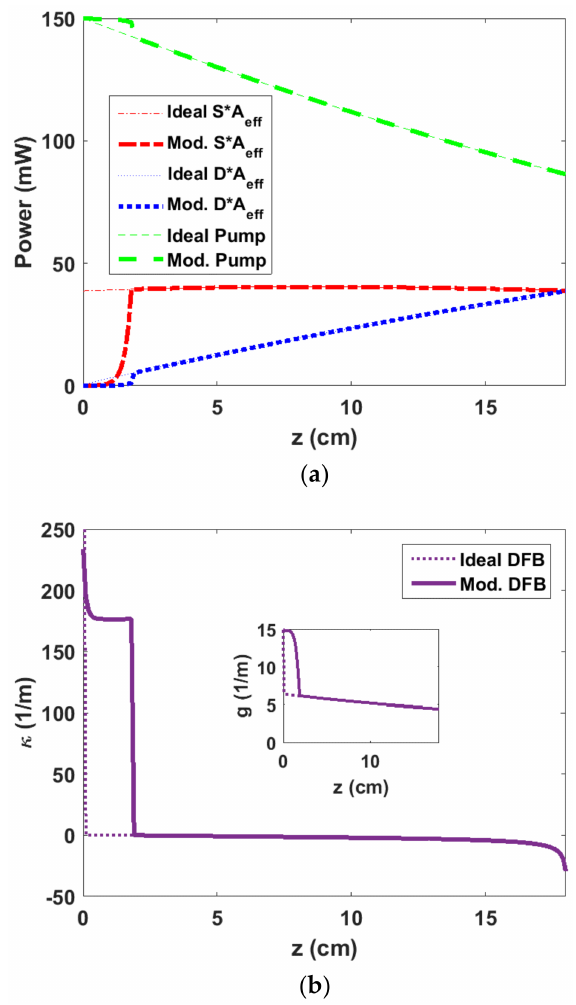
Figure 5. ( a ) Modified distribution of SA eff and DA eff and P p as a function of EDF-DFB length for a pump power of 150 mW and a loss of 0.3 dB/m. An exponential distribution for S is considered before PPS position at 1.9 cm, and the realistic non-zero NS output power is assumed to be as low as 10 µ W. ( b ) Modified coupling coefficient vs. length for an 18-cm-long DFB with a maximum coupling of 234 m − 1 . The inset shows the gain vs. the DFB